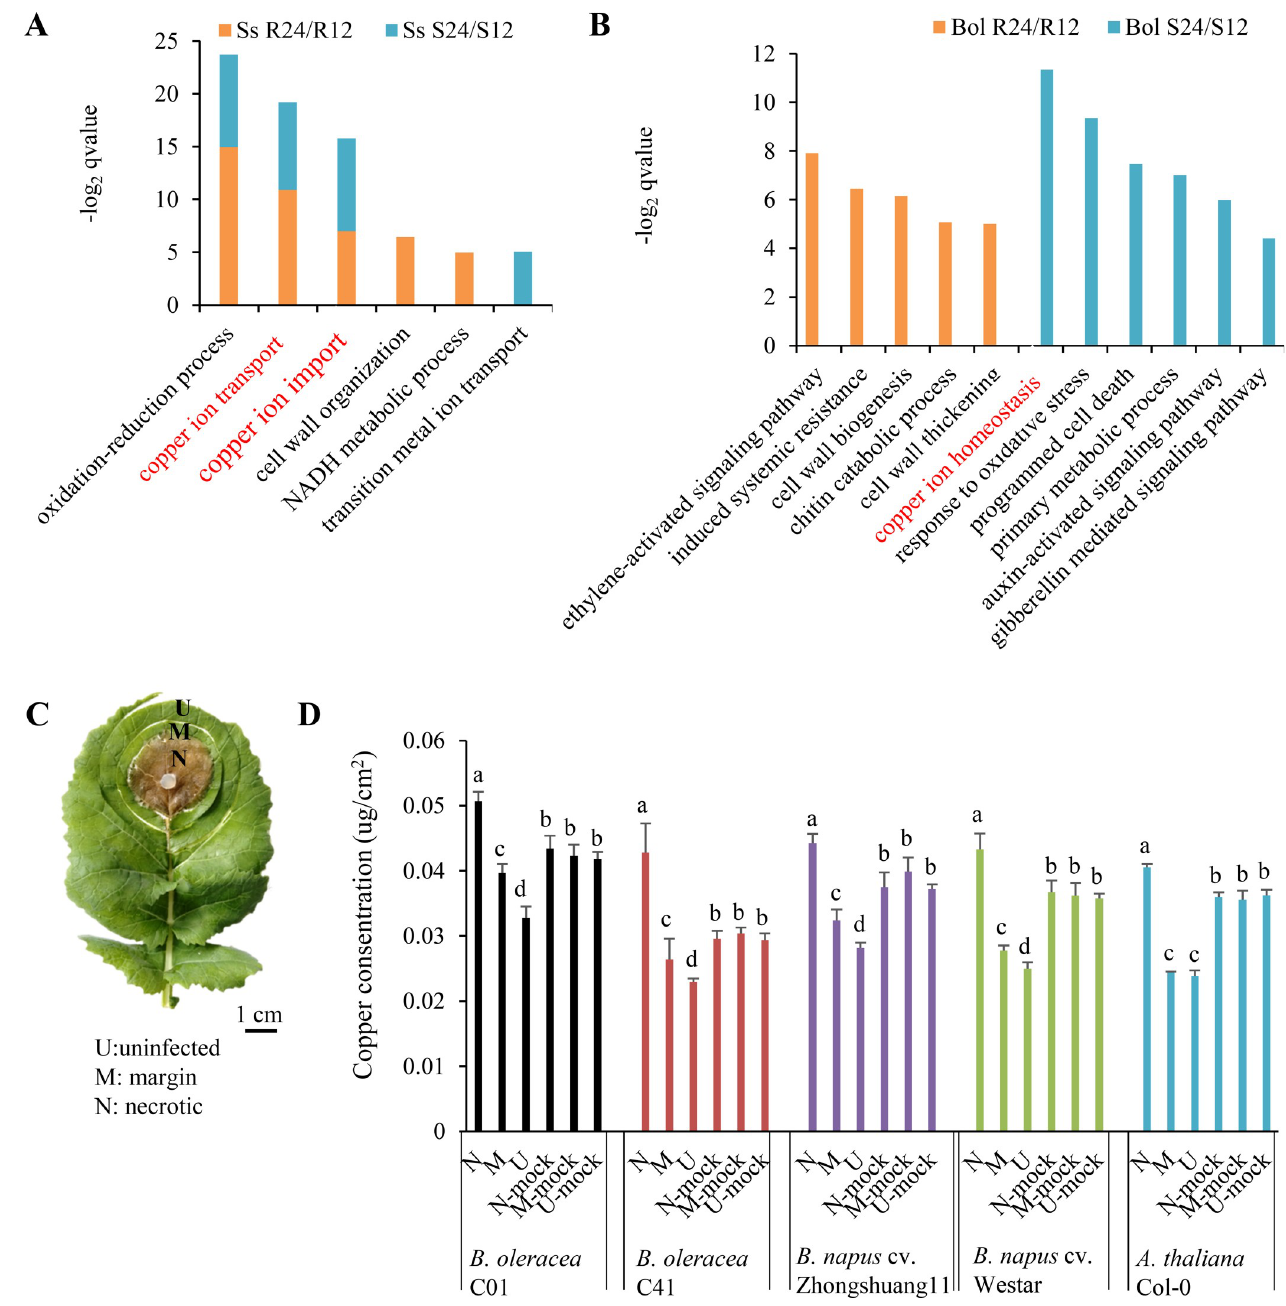
Fig 1. Copper is involved in the interaction between Brassica oleracea and Sclerotinia sclerotiorum . (A) Gene Ontology (GO) biological processes represented by S . sclerotiorum DEGs (differentially expressed genes; 24 hours post inoculation [hpi] vs 12 hpi) in infected B . oleracea . (B) GO biological processes represented by resistant and susceptible B . oleracea DEGs (24 hpi vs 12 hpi). Ss R24/R12: S . sclerotiorum DEGs in resistant B . oleracea identified by comparing 24 hpi to 12 hpi; Ss S24/S12: S . sclerotiorum DEGs in susceptible B . oleracea identified by comparing 24 hpi to 12 hpi; Bol R24/R12: B . oleracea DEGs in resistant B . oleracea identified by comparing 24 hpi to 12 hpi; Bol S24/S12: B . oleracea DEGs in susceptible B . oleracea identified by comparing 24 hpi to 12 hpi. (C) Schematic workflow of tissue sampling in copper content analysis. (D) Copper concentration in uninfected (U), margin (M), necrotic (N) and mock tissues of resistant parental B . oleracea C01, susceptible parental B . oleracea C41, resistant B . napus cv. Zhongshuang 11 and susceptible B . napus cv. Westar leaves at 48 hpi and in A . thaliana wild-type Col-0 at 12 hpi. Error bars indicate the standard deviation of three independent replicates with six leaves for every sample in one replicate. Different letters indicate statistically significant differences ( P < 0.05, Student’s t -test).